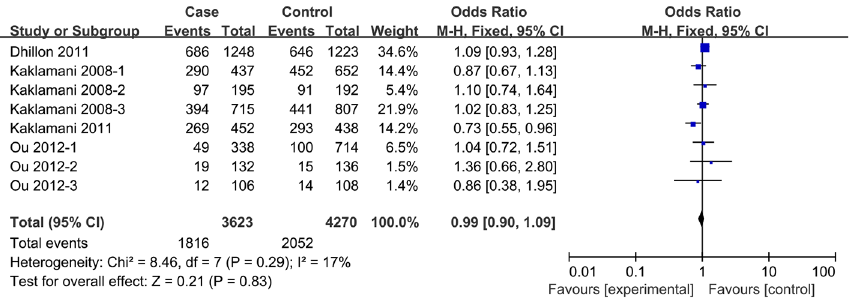
Fig 5. Forest plot of the association between ADIPOR1 SNP rs12733285(C/T) and cancer risk in a dominant model after sensitivity analysis.